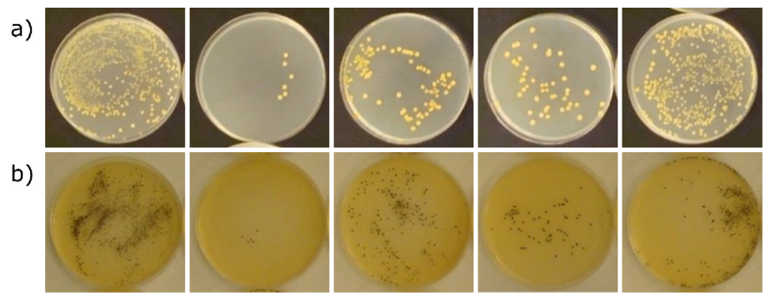
Figure 7. Growth of Staphylococcus aureus on PCA ( a ) and Baird–Parker ( b ) media after culturing the suspension samples recovered from the test materials after 24 h of incubation under optimal growth conditions. From left to right: perlite, Na-Z, Ni-Z, Cu-Z, and Zn-Z.